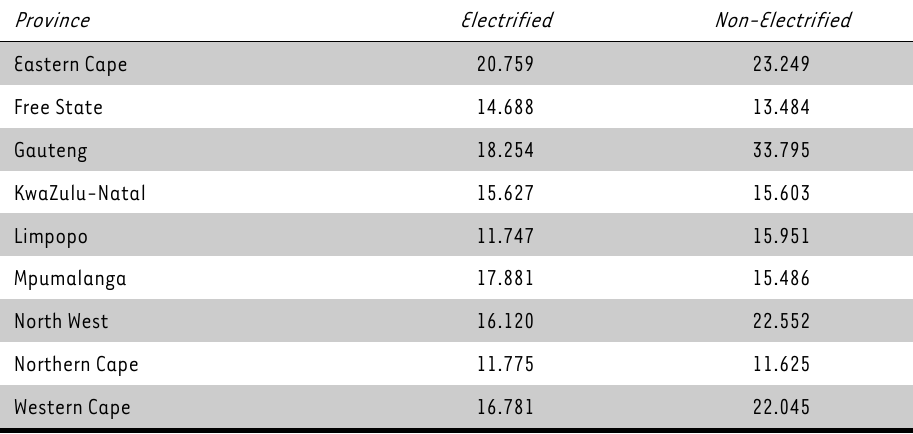
Energy expenditure as a percentage of total monthly household income, by province Province Electrified Non-Electrified Eastern